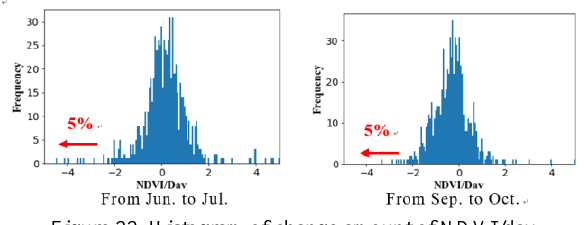
Figure 22. Histogram of change amount of NDVI/day